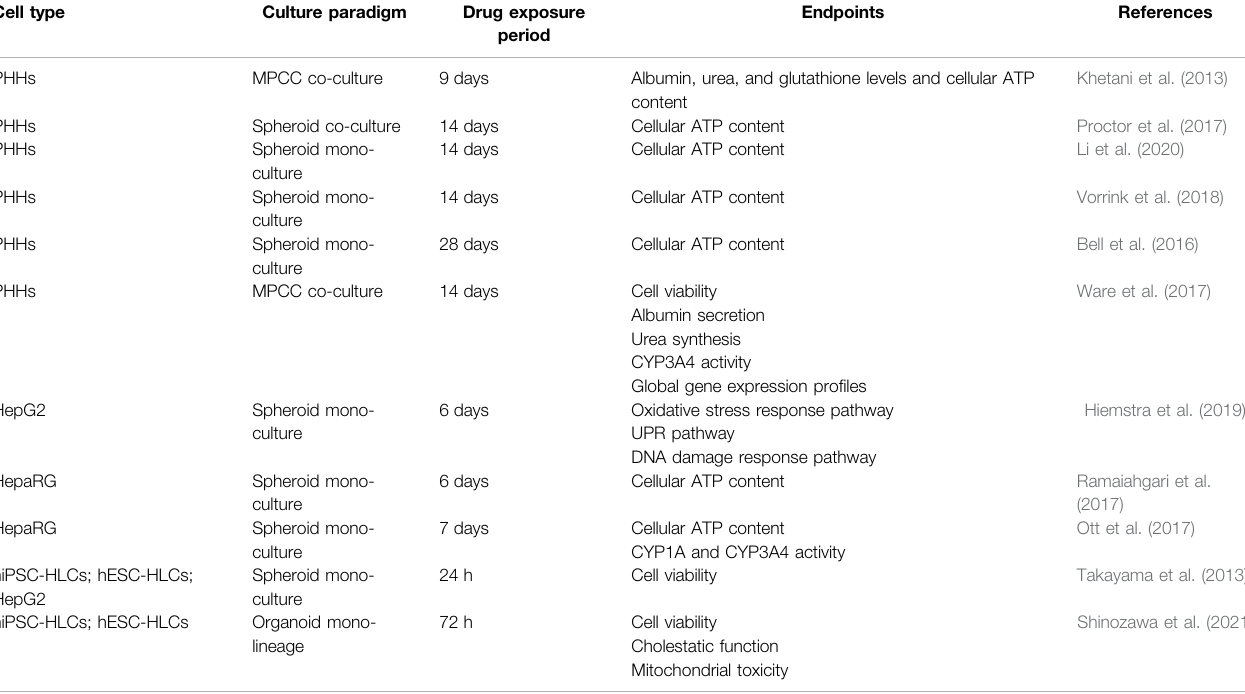
TABLE 2 | Selected hepatotoxin screening using 3D hepatic models established with different cell types. Cell